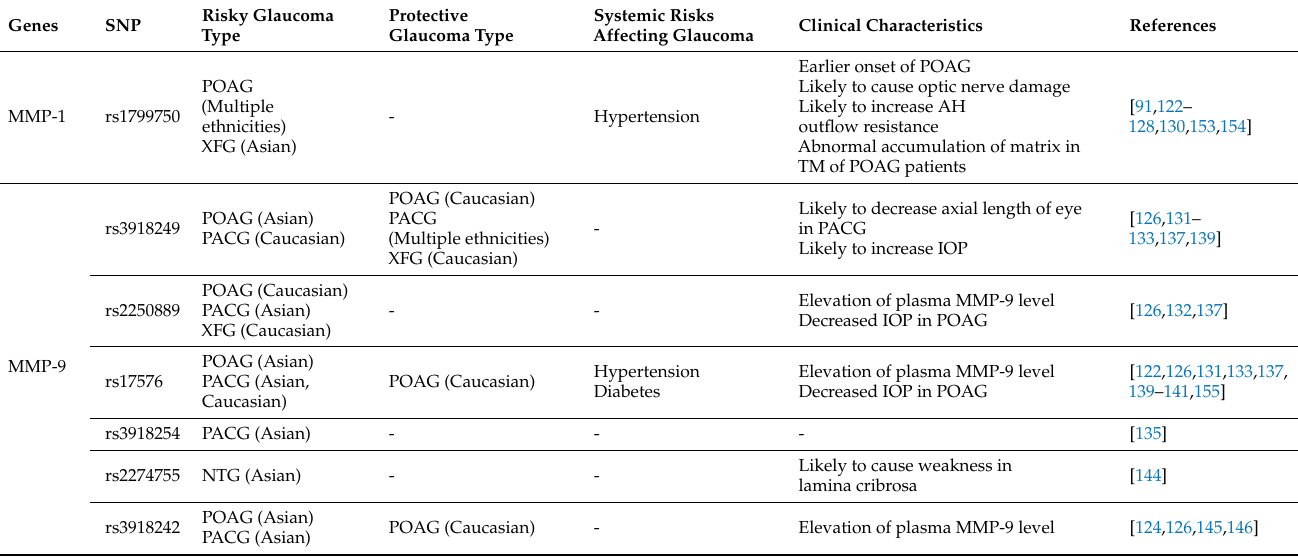
Table 2. Matrix metalloproteinase (MMP) gene single-nucleotide polymorphisms (SNP) likely to affect glaucoma